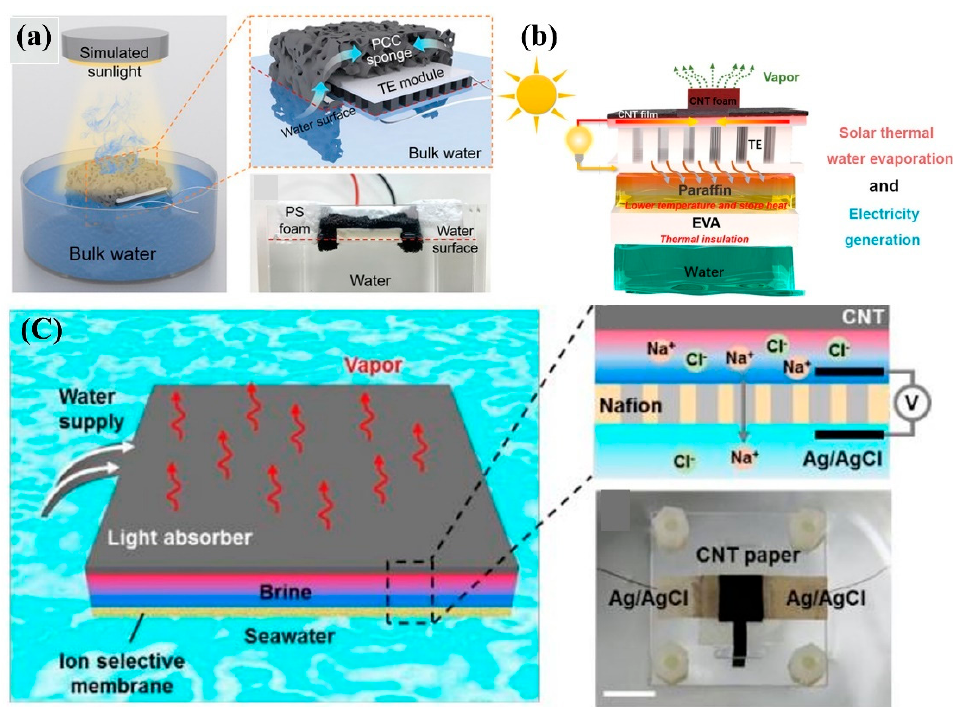
Figure 8. ( a ) Schematic diagram of the successive generation of water and steam using a CNT composite sponge as a solar absorber (reproduced with permission, Copyright 2019 John Wiley and Sons [73]). ( b ) Illustration of CNT/TE/paraffin/EVA/water hybrid structure steam and electricity generation (reproduced with permission, Copyright 2021 American Chemical Society [72]). ( c ) Mechanism of the hybrid device for water purification and electricity generation from salinity gradient (reproduced with permission, Copyright 2017 The Royal Society of Chemistry [86]).